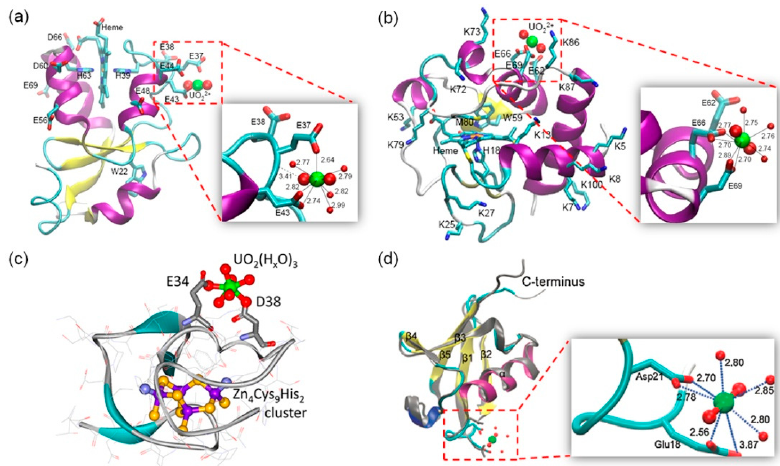
Figure 2. Modeling structures of UO 22+ binding to protein surface. ( a ) A model of UO 22+ binding to Cyt b 5 at surface residues, Glu37 and Glu43 [44]; ( b ) A model of UO 22+ binding to Cyt c at surface residues, Glu66 and Glu69 [45]; ( c ) A model of UO 22+ binding to Zn 4 SmtA species. Reprinted with permission from Ref. [49], Copyright 2016 American Chemical Society; ( d ) A model of UO 22+ binding to Ub at surface residues, Glu18 and Asp21 (cyan). The structure of free Ub (gray) was shown for comparison [53]. Close-up views of the uranyl binding sites were shown as insets, highlighting the coordination and H-bonding interactions.